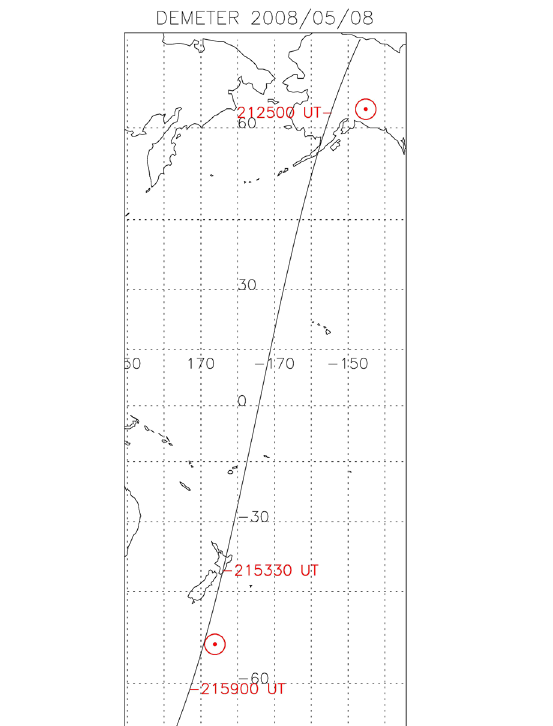
Fig. 11 Orbit of DEMETER on 8 May, 2008 with times showing the positions of HAARP and its magnetically conjugate point